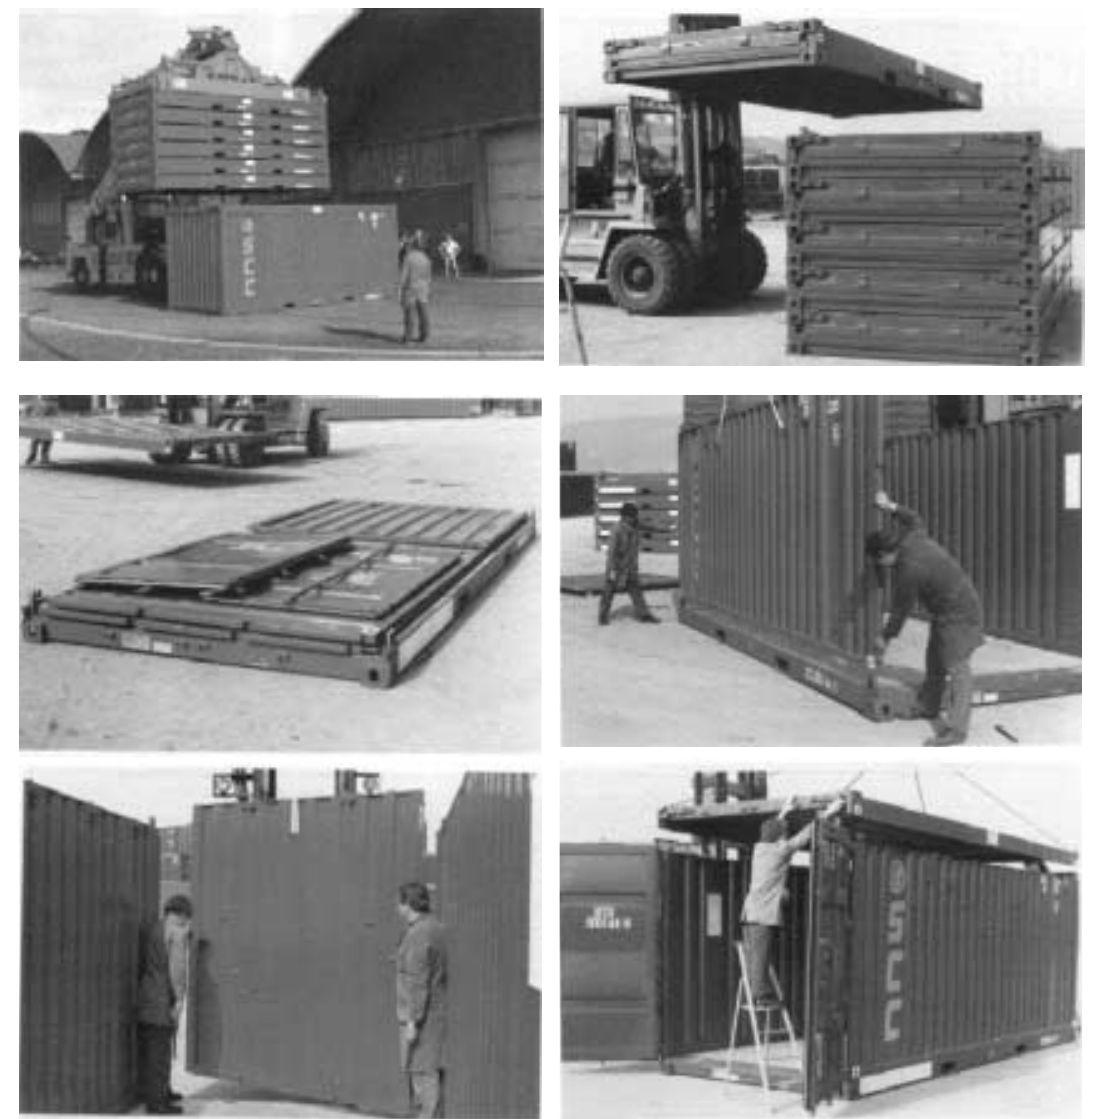
Figure 1. The folding process of the Six-in-One